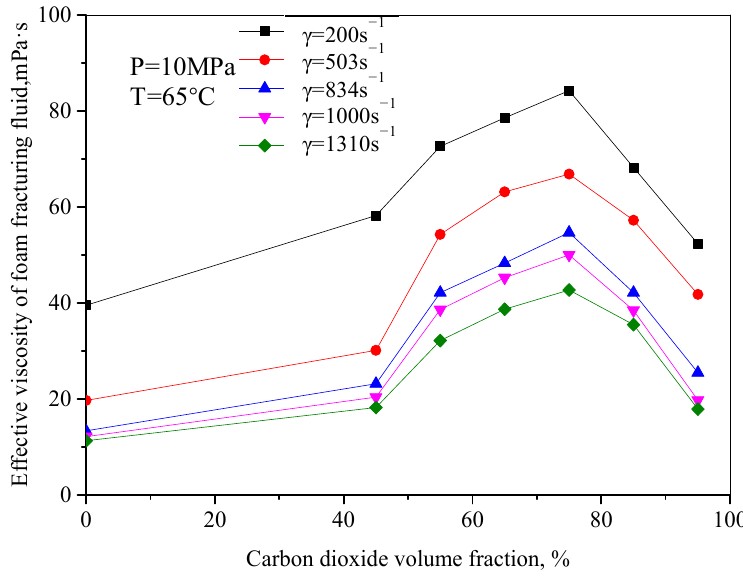
Figure 4. Variation curve of effective viscosity with foam quality (Foamed, T = 65 °C).